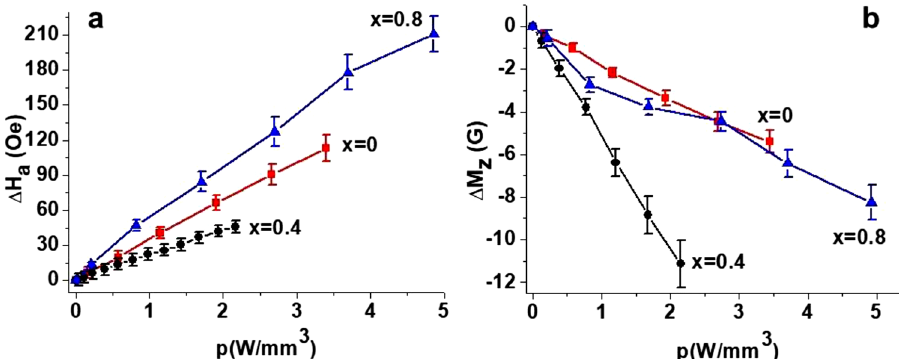
Figure 6. Changes in the uniaxial anisotropy field ( a ) ∆H a and ( b ) saturation magnetization ∆M z as a function of applied electric power p for SrAl x Fe 12−x O 19 for x = 0. 0.4 and 0.8.